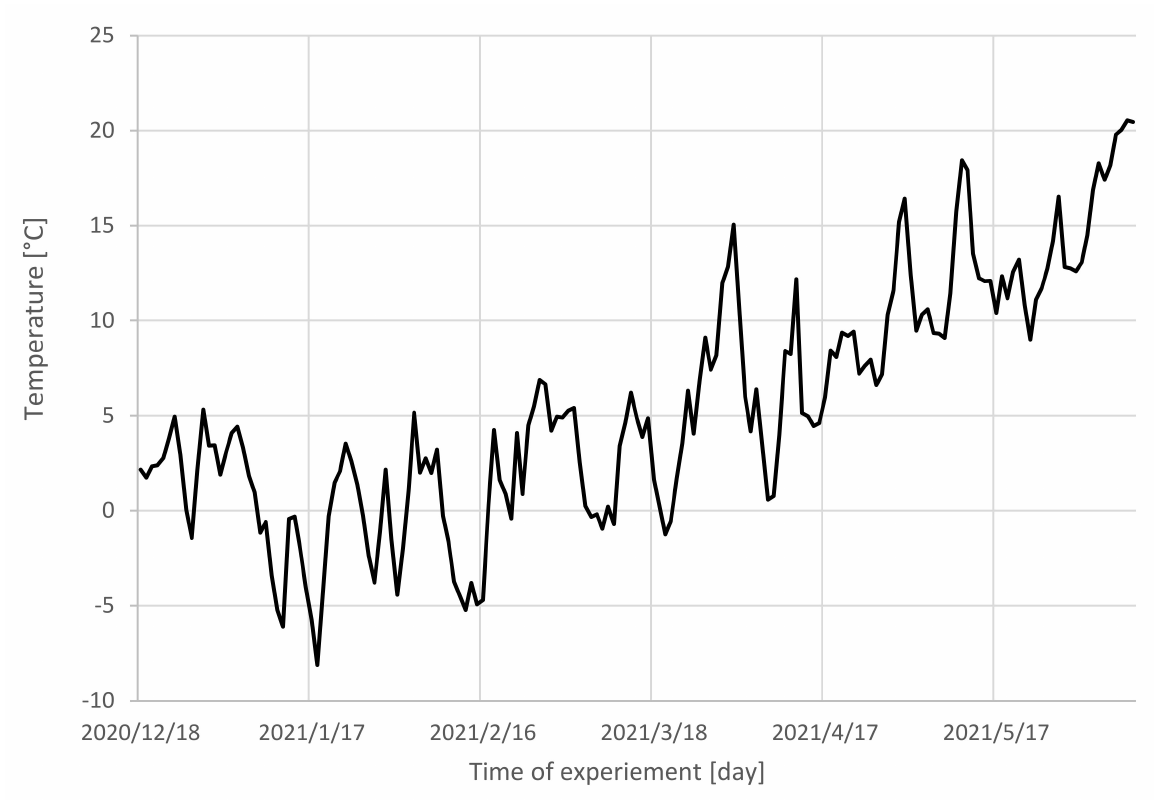
Figure 4. Air temperature in the roundwood environment during the 6-month-long storage. A decrease in density in a dry state after the 6-month-long storage is evident (Figure 5). The decrease in density can be observed on the surface of the roundwood, while in the centre—in the ripewood—only a slight change occurred (Figure 5).